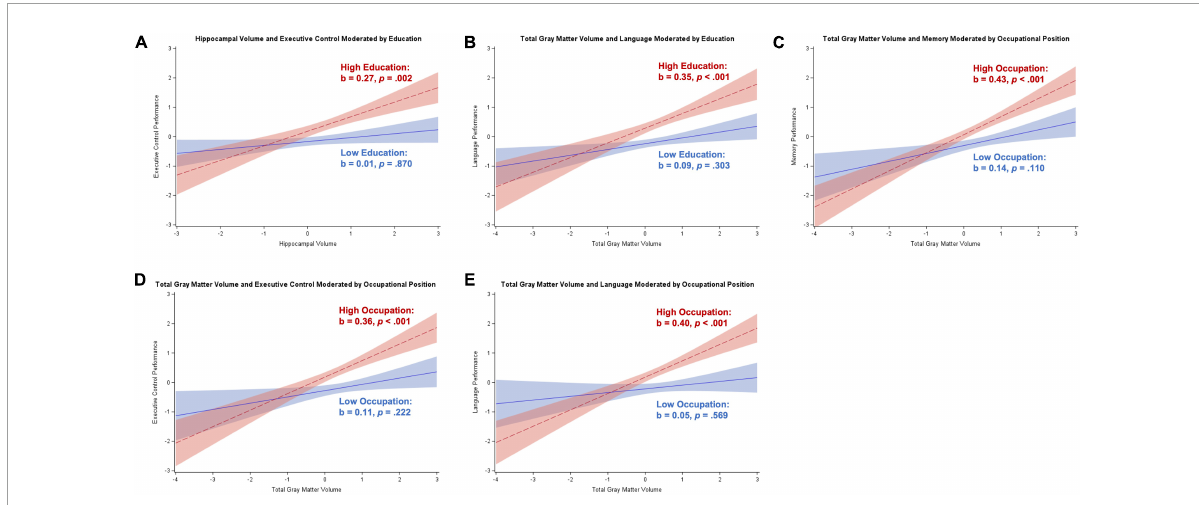
FIGURE7 Plots of significant moderations by education and occupational position of the associations between brain volume and cognition for women without dementia. High education or occupational position corresponds to 1 SD above the mean and low education or occupational position corresponds to 1 SD below the mean. The red dotted line represents high education or occupational position, and the blue solid line represents low education or occupational position. Shaded areas represent 95% confidence intervals. Cognition and brain volume were standardized. (A) Significant positive association between hippocampal volume and executive control for participants with high education; non-significant positive association for low education. (B) Significant positive association between total gray matter volume and language for participants with high education; non-significant positive association for low education. (C) Significant positive association between total gray matter volume and memory for participants with high occupational position; non-significant positive association for low occupational position. (D) Significant positive association between total gray matter volume and executive control for participants with high occupational position; non-significant positive association for low occupational position. (E) Significant positive association between total gray matter volume and language for participants with high occupational position; non-significant positive association for low occupational